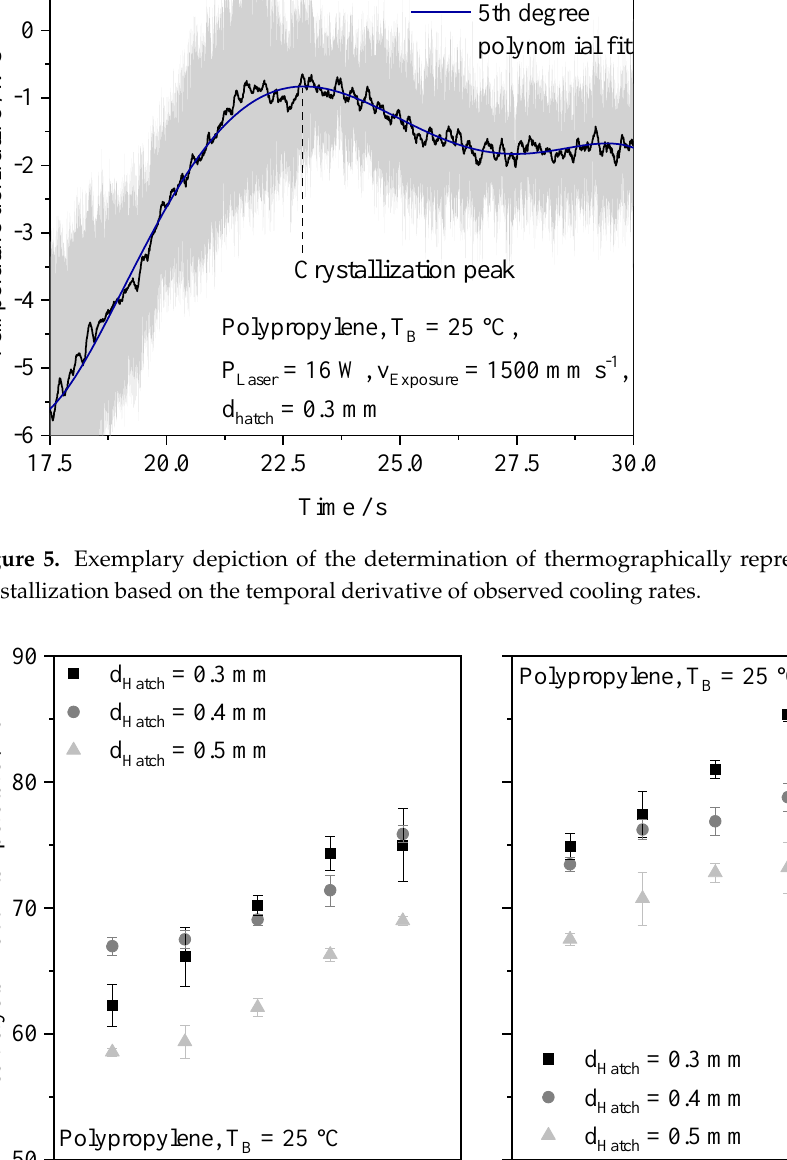
Figure 4. Influence of hatch distance and laser power on emerging time – temperature profiles, v Exposure = 1500 mm s −1 .